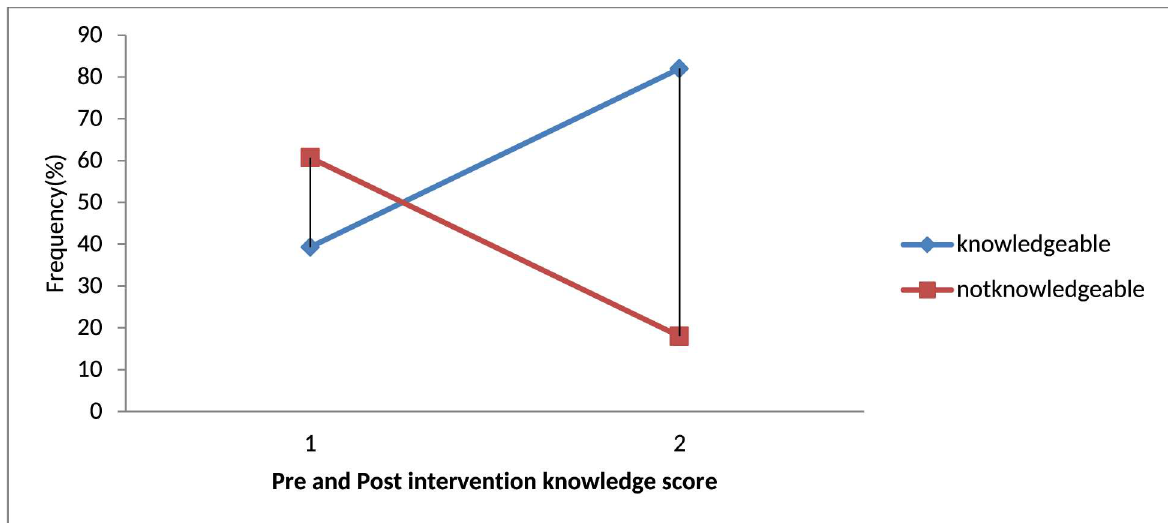
Fig 1. Pre- and post-interventions knowledge level of respondents in Hawassa Health Sciences College, 2015.